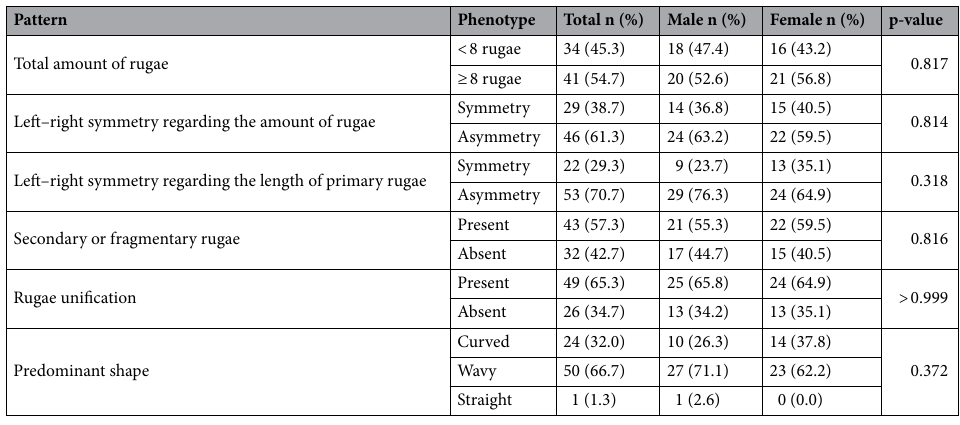
Table 1. Distribution of palatal rugae patterns according to gender (n =